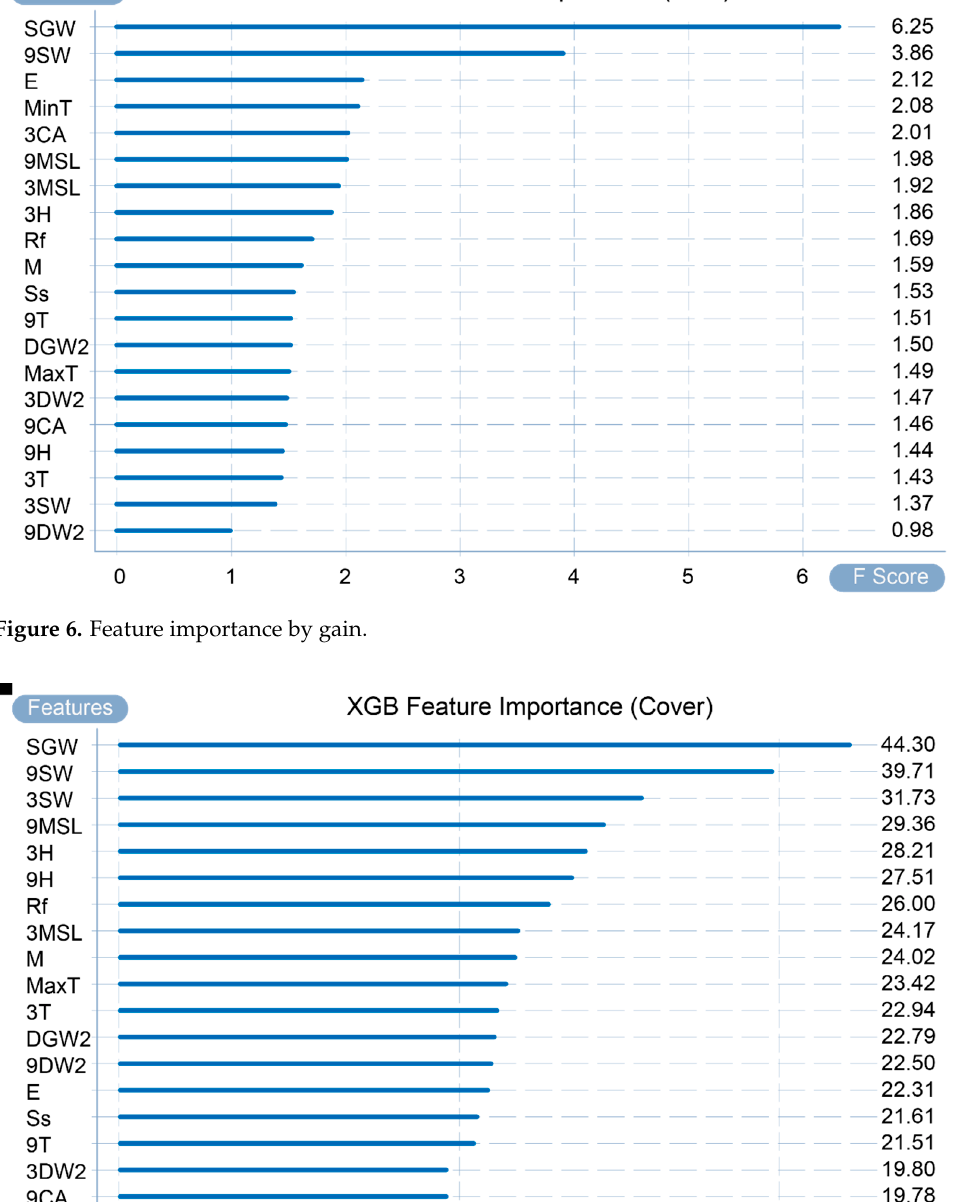
Figure 5. Feature importance by weight.